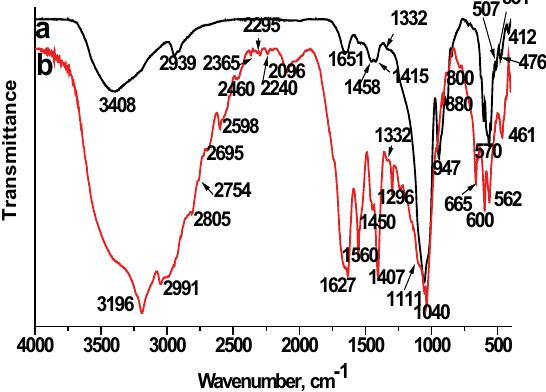
Figure 6. FTIR spectra of collagen/silicocarnotite coatings, after immersion in 1.5SBF with different quantity of collagen and silicocarnotite: 25:75 wt.% (a) and 75:25 wt.%